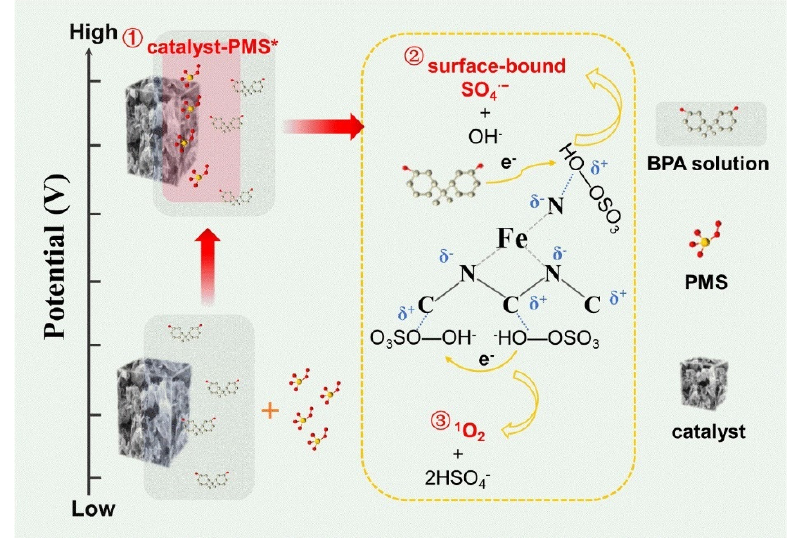
Figure 5. Mechanism of removal of BPA by FeCN x /PMS system [91].